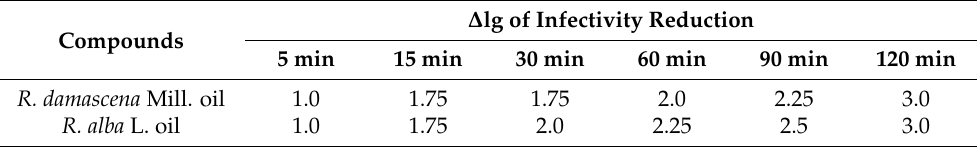
Table 2. Virucidal activity against HSV-1 (Victoria strain) virions of Rosa damascena Mill. and Rosa alba L. essential oils.